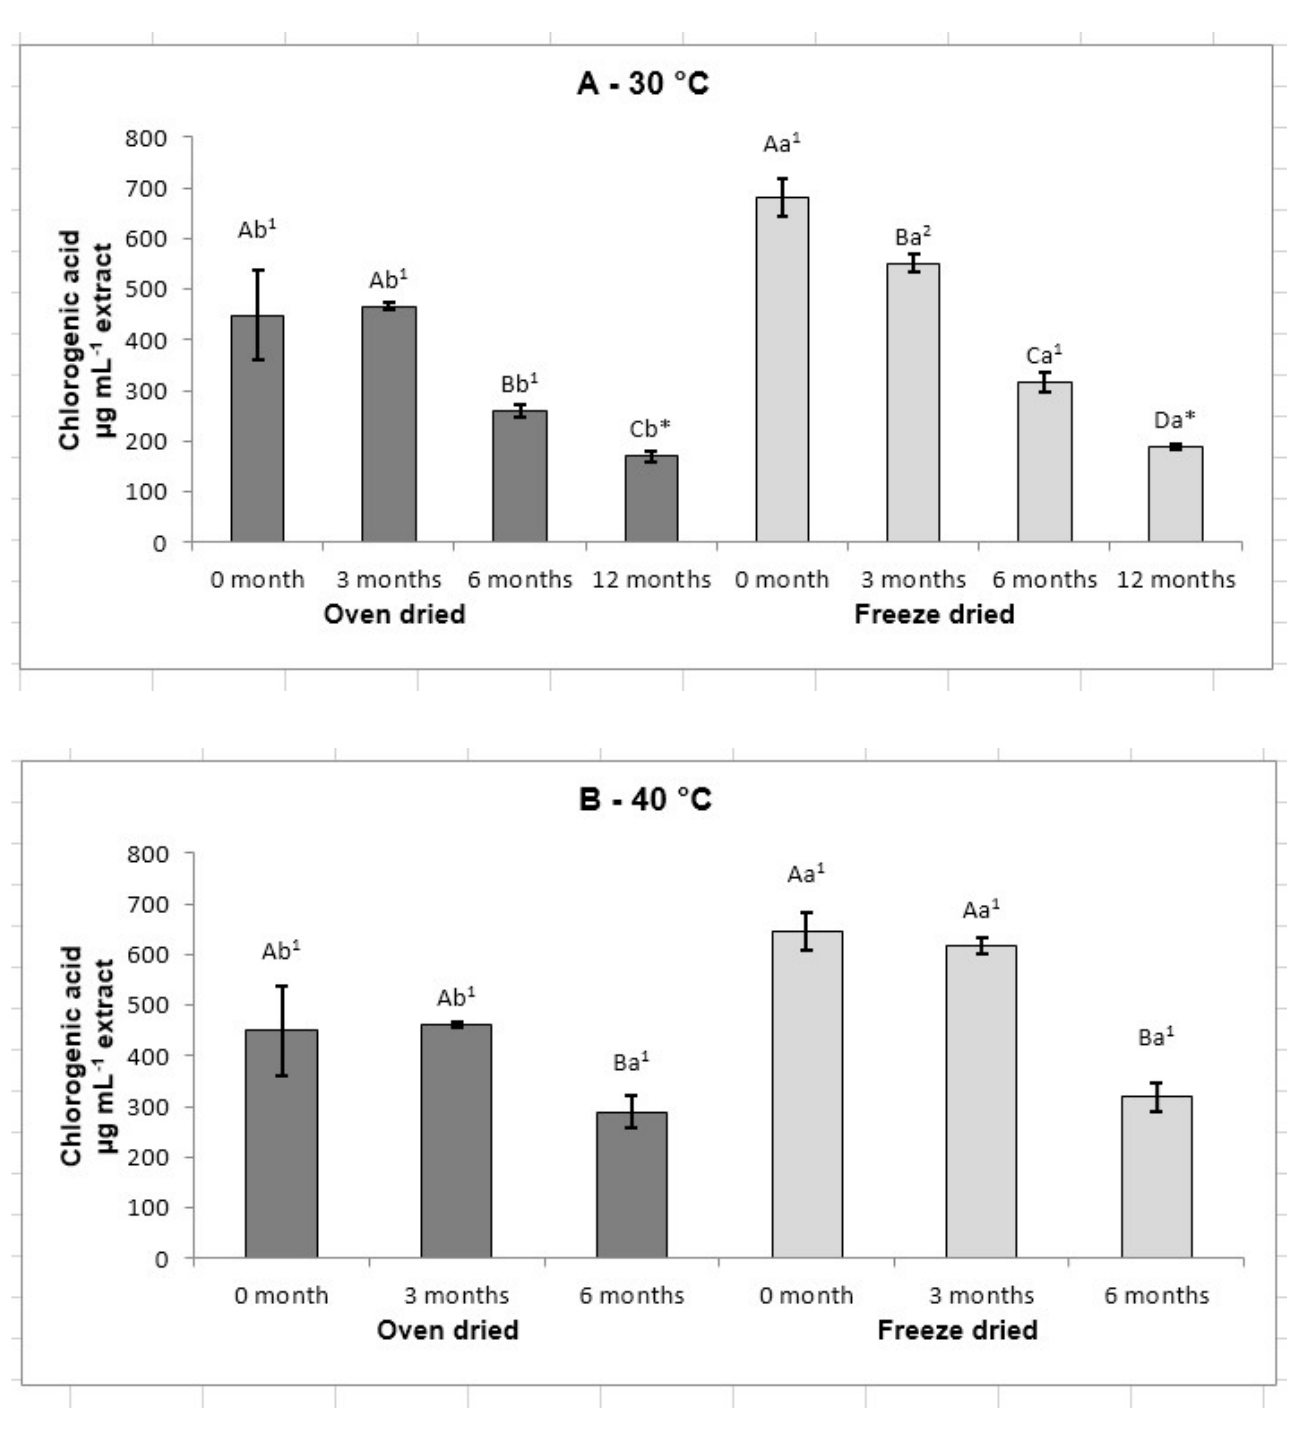
FIGURE 1 - Variation of the content of chlorogenic acid in extracts of oven dried and freeze-dried M. glomerata leaves. (A) long-term stability study at 30 ºC and (B) accelerated stability study at 40 ºC. (*) Indicates no data collected for this group. Capital letters indicate statistically significant (p<0.05) differences within the same drying method (0, 3, 6 and 12 months). Lowercase letters indicate statistically significant (p<0.05) differences between drying methods at the same time. Numerals indicate statistically significant (p<0.05) differences between storage temperatures (30 ºC and 40 ºC). Experiment performed in triplicate. Error bars indicate standard